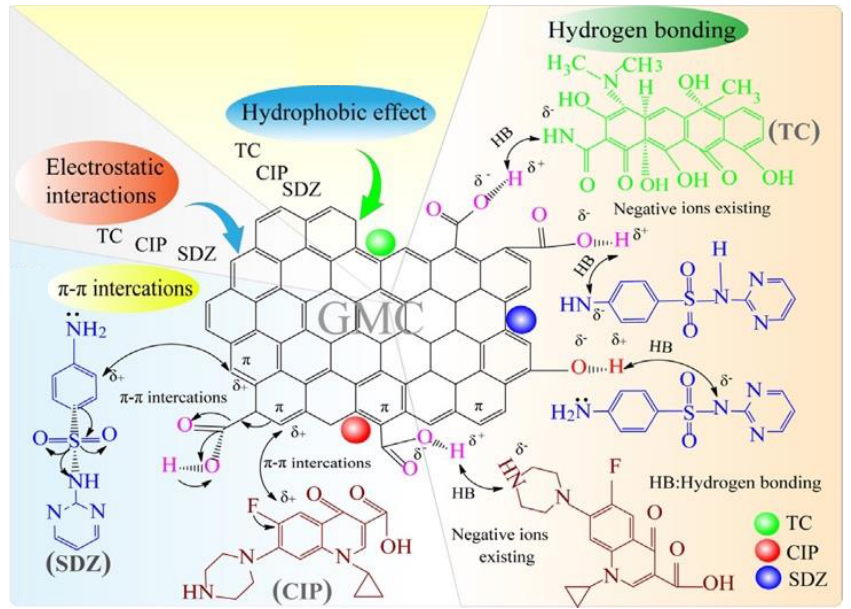
Figure 4. The mechanisms of the target antibiotics adsorption on GMC surface from aqueous solutions. Adapted with permission from [62].